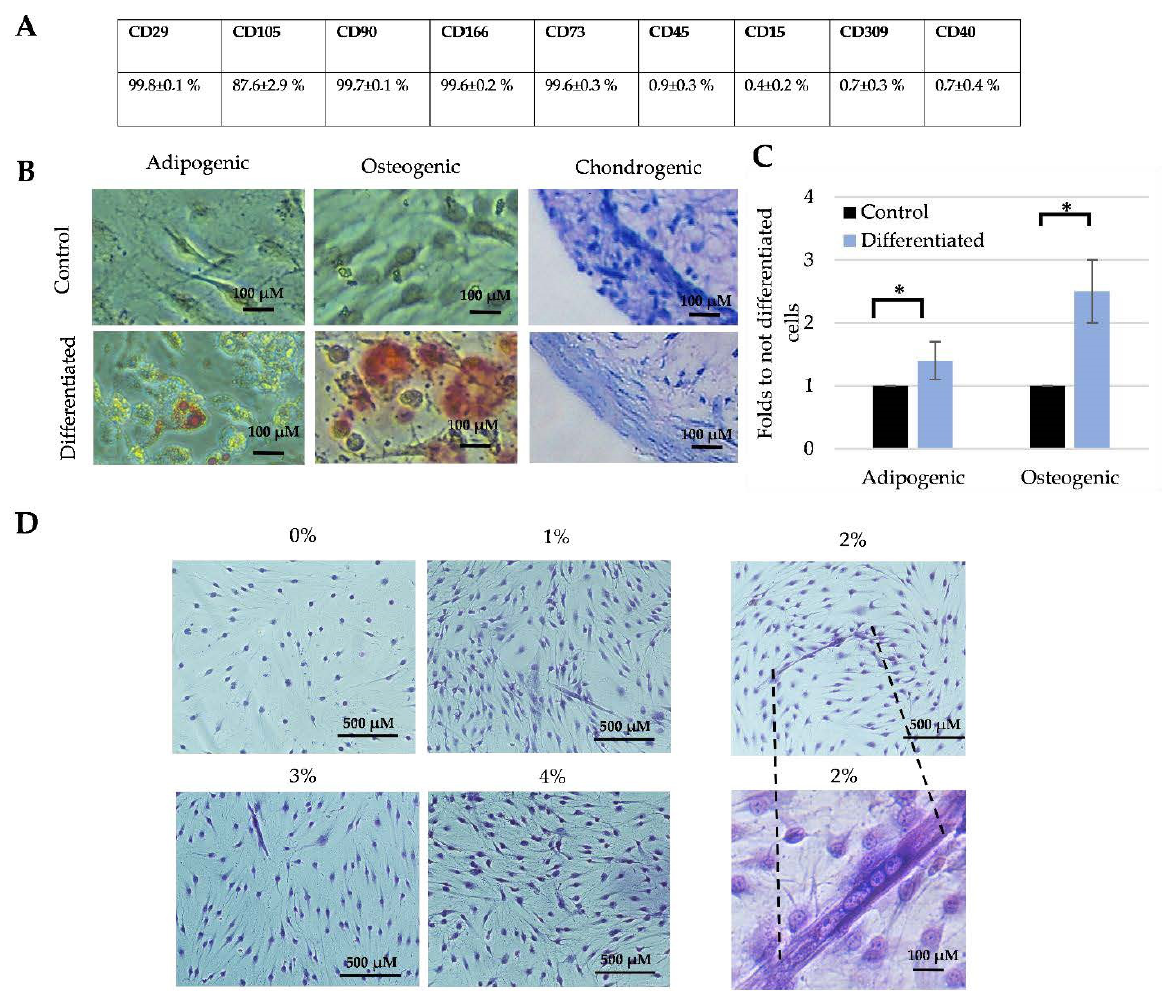
Figure 2. The multipotency of total SM-MSCs population isolated from human skeletal muscle. ( A ) MSCs-typical cell surface marker profile investigated by flow cytometer. ( B ) Qualitative evaluation of adipogenic, osteogenic and chondrogenic differentiation. ( C ) Quantitative evaluation of adipogenic and osteogenic differentiation. ( D ) Myogenic differentiation depending on the FBS concentration. Data are shown as mean ± standard deviation (SD) from not less than three repeats ( n = 3) and three cell cultures calculated using the Excel software and are significant at * p ≤ 0.05 level.